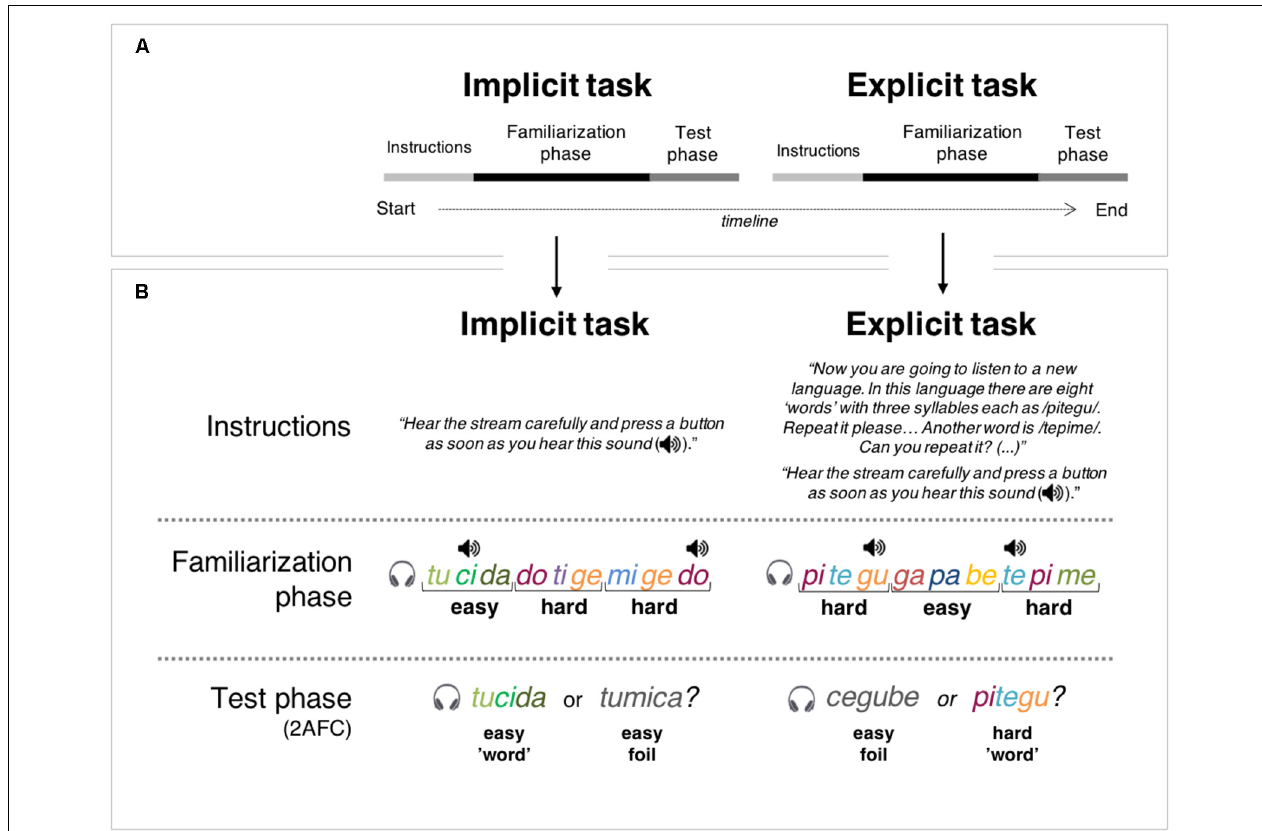
FIGURE 1 | Visual summary of experimental design. Note: Box (A) illustrates the timeline of the experimental procedure in which one implicit and, subsequently, one explicit auditory statistical learning (SL) tasks were administered. Each task of the two tasks comprised of three parts: instructions, familiarization phase, and test phase. As can be observed in Box (B) , each task was initiated with specific instructions that determined the conditions under which SL occurred: implicit instructions (i.e., without knowledge of the stimuli or the structure of the stream—Implicit task) or explicit instructions (i.e., with explicit knowledge or pre-training on the “words” presented in the stream—Explicit task). In the familiarization phase of both tasks, participants were presented with a continuous auditory stream of four easy and four hard “words,” with chirp sounds (depicted as a speaker icon on the Figure) superimposed over specific syllables. The chirp sounds could emerge at any of three-syllable positions of the “words,” which precluded its use as a cue for stream segmentation. During this phase, participants had to perform a chirp detection cover task. Then, a test phase consisting of a two-alternative forced-choice (2-AFC) task asked participants to indicate which of two syllable-sequences (a “word” and a foil) sounded more familiar considering the stream heard on the familiarization